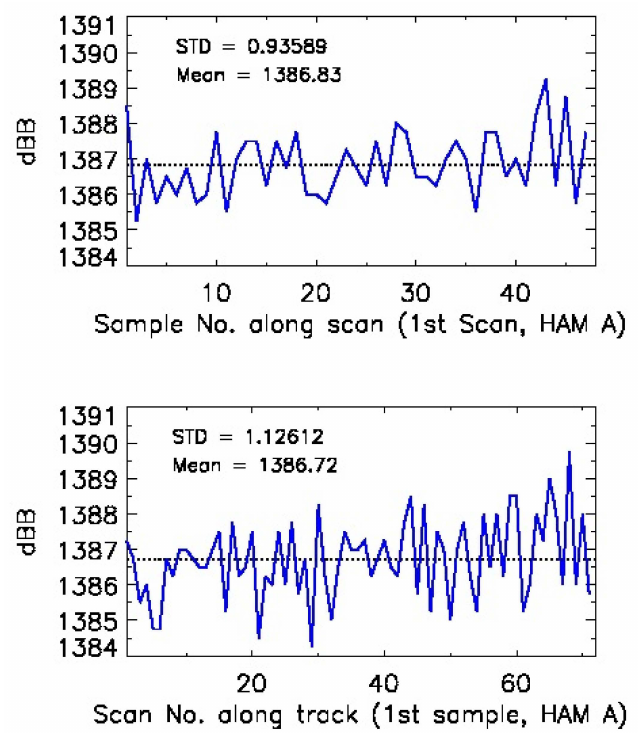
Figure 11. The variation of dBB with 48 samples for one scan ( top ) and the variation of dBB with scan for detector 1 and 1st sample along track ( bottom ) in M15 for three continuous granules (t0755_e0756, t0756_e0758, and t0758_e0759) on 30 June 2015. Dashed line refers to the averaged